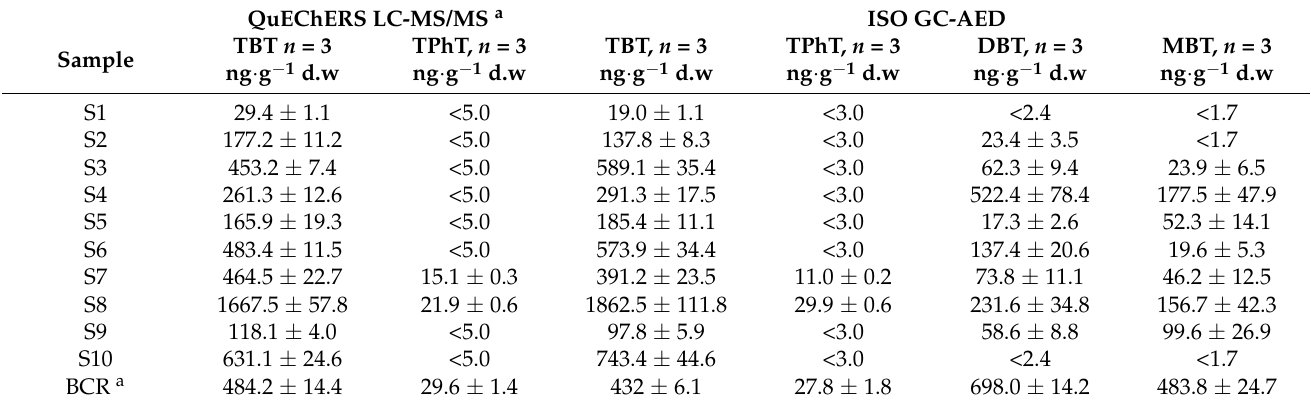
Table 2. The results of (TBT), triphenyltin (TPhT), dibutyltin (DBT), and monobutyltin (MBT) deter- mination in real sediments samples and reference material of freshwater sediment (BCR 646) by the